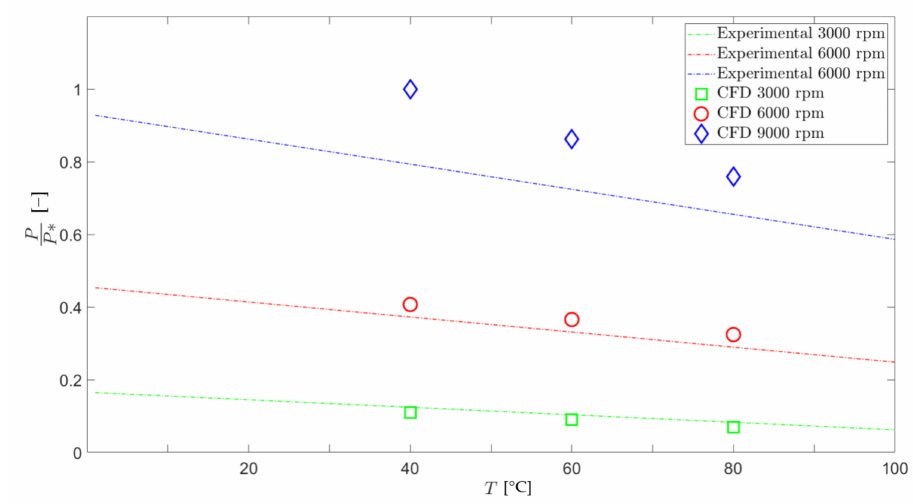
Figure 7. Power losses vs temperature for the three rotation velocities.